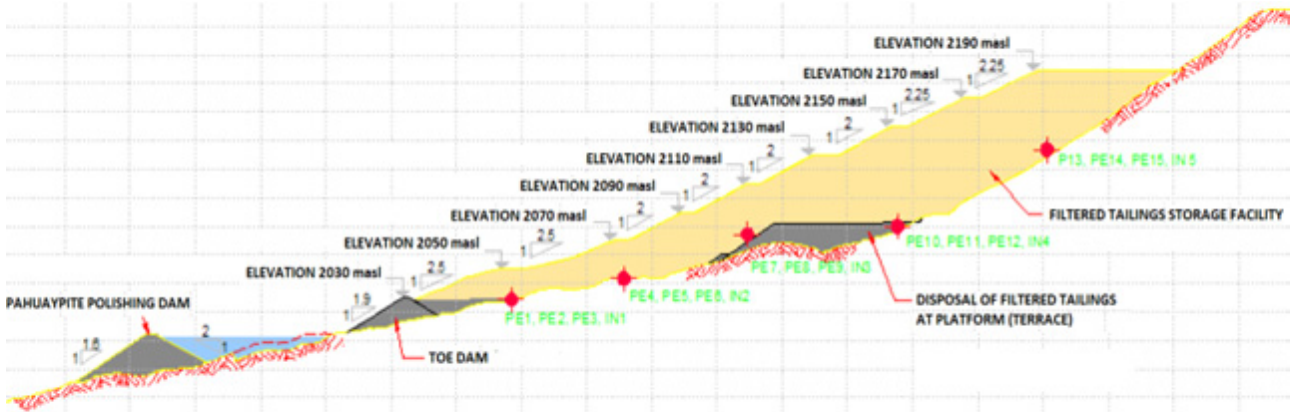
Figure 56. Cerro Lindo Filtered TSF Typical Cross Section [20,21,25].